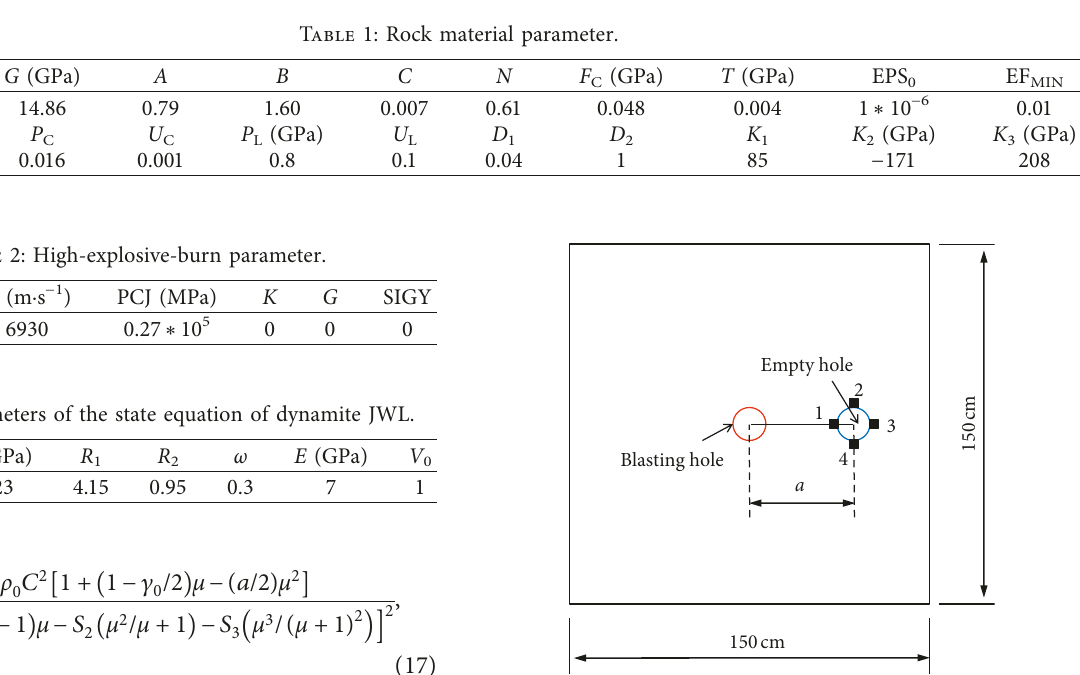
Figure 4: Comparison test of different distances between holes. Table 4: Experimental group parameters of different distances between